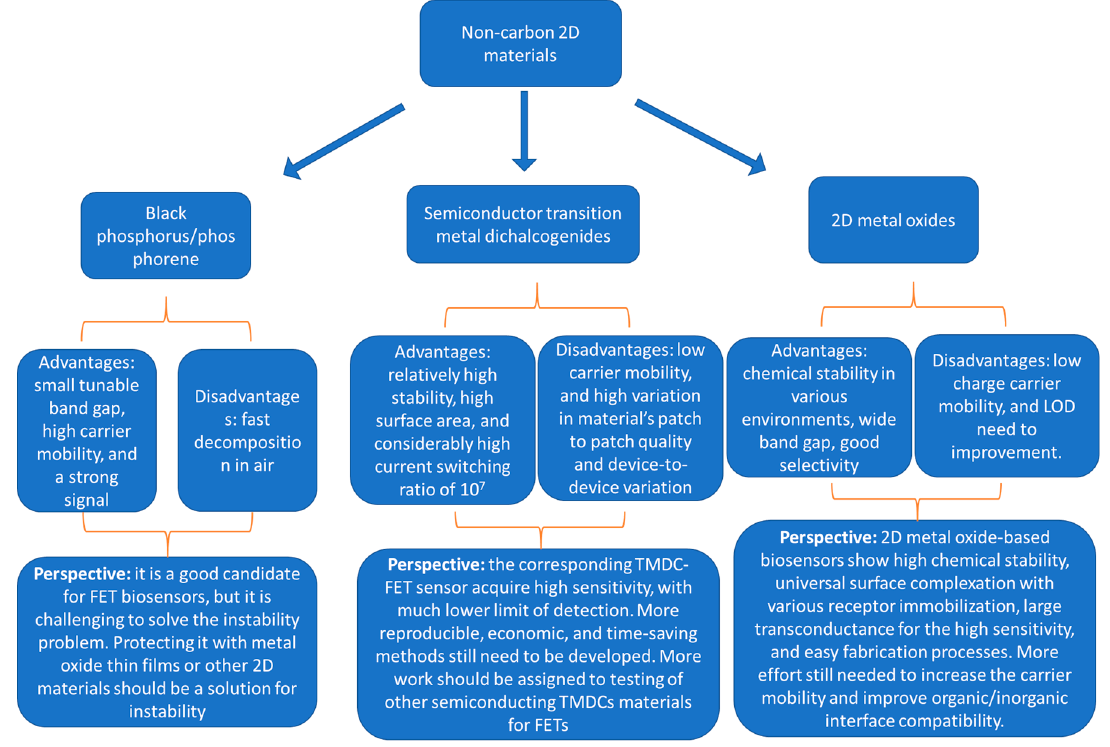
Figure 8. A schematic diagram summarizing the non-carbon 2D materials, their advantages and disadvantages as channel materials for FET biosensor applications, and the authors perspectives about them.